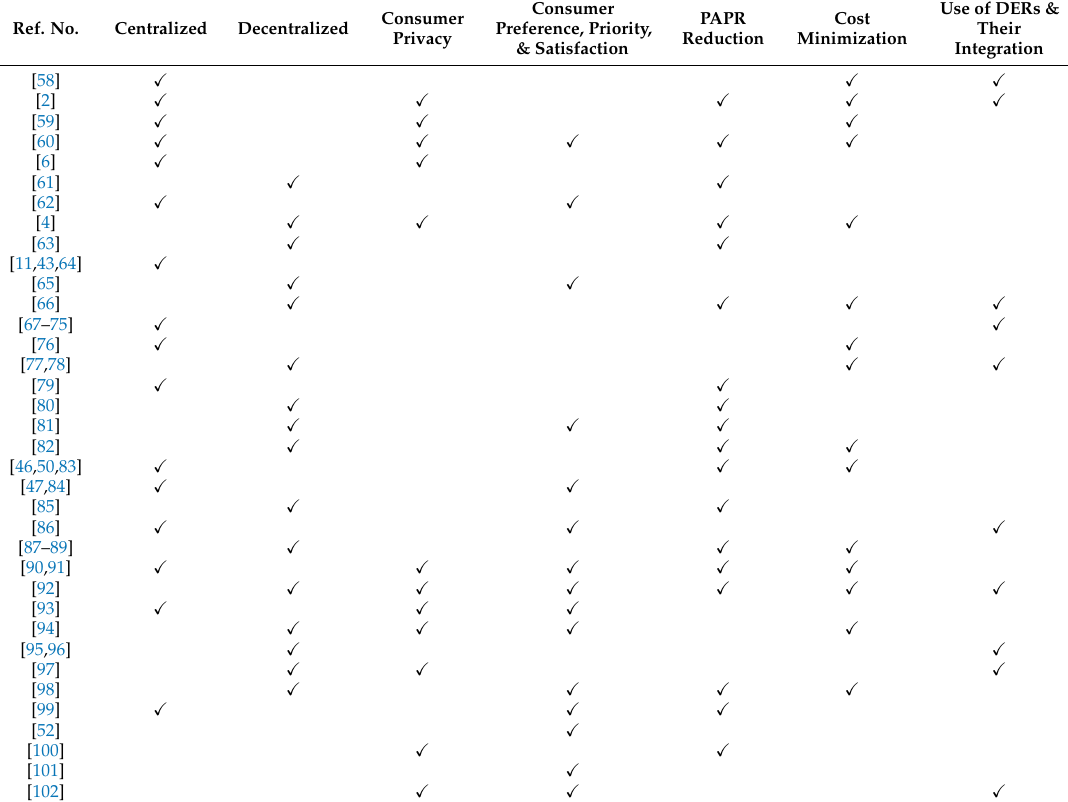
Table 6. Classification of performance metrics related to energy management in the smart grid. Ref.